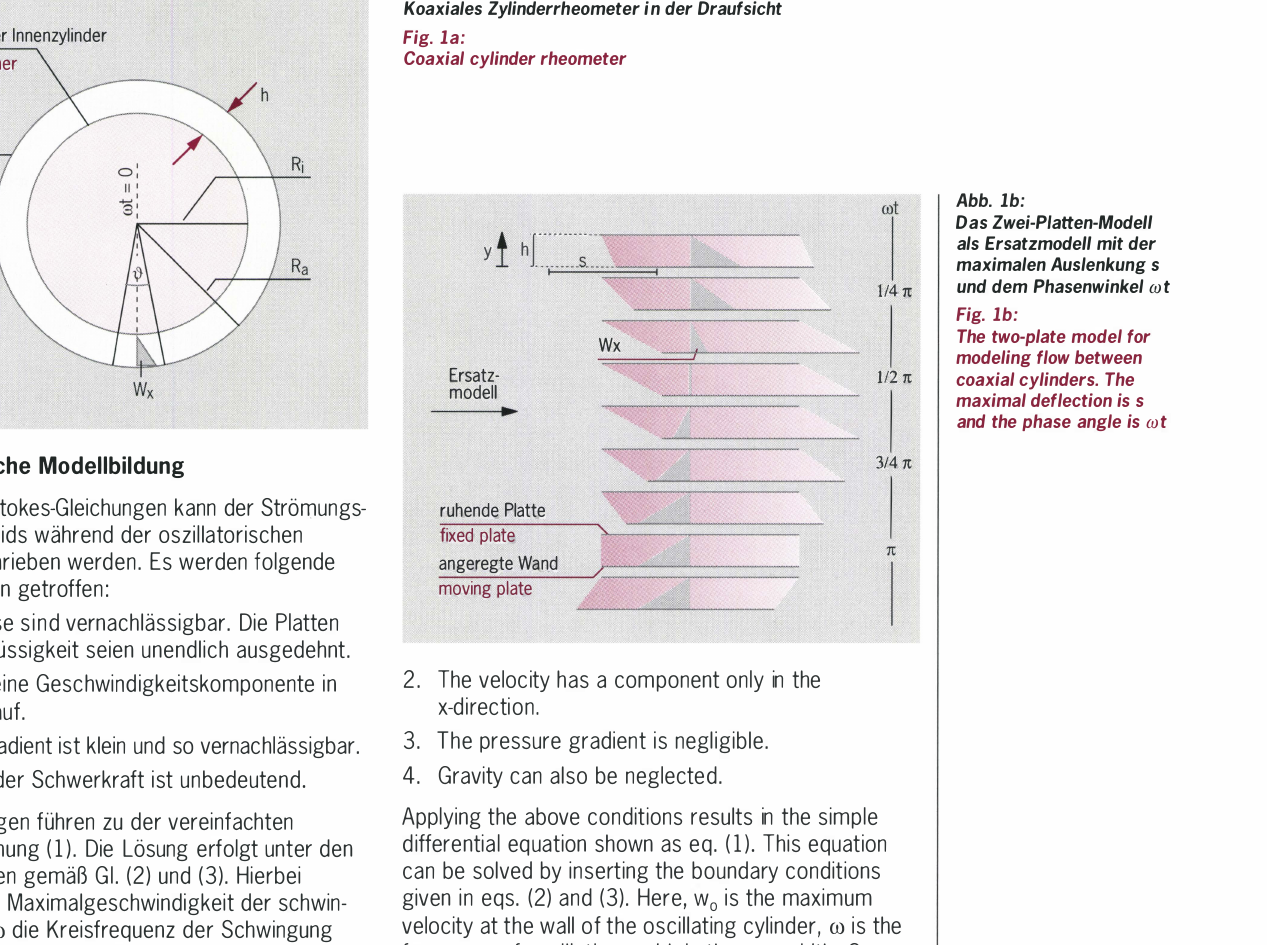
Fig. la: Coaxial cylinder rheometer